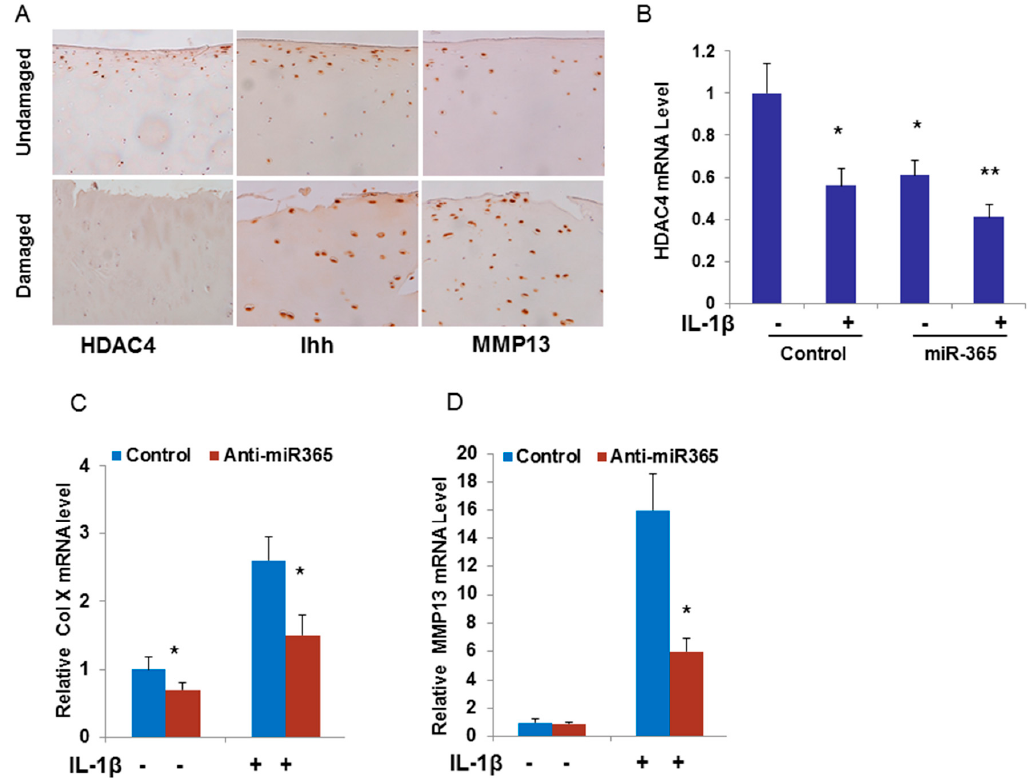
Figure 6. miR-365 targets HDAC4 and mediates the catabolic effect in chondrocytes. ( A ) Immunohistochemical analysis of HDAC4, Indian Hedgehog (Ihh) and MMP13 in cartilage sections from OA patients; ( B ) Human articular chondrocytes were transfected with miR-365 mimic and control mimic for 24 h then treated with (+) or without ( − ) 10 ng/mL IL-1 β for 24 h. RNA was collected and mRNA levels of HDAC4 were detected by real-time PCR. * p < 0.05; ** p < 0.01, compared with control mimic transfection without IL-1 β treatment; ( C , D ) Human articular chondrocytes were transfected with anti-miR-365 inhibitor for 24 h then treated with (+) or without ( − ) 10 ng/mL IL-1 β for 24 h. RNA was collected and mRNA levels of Col X and MMP13 were detected by real-time PCR. * p < 0.05, compared with control inhibitor transfection.